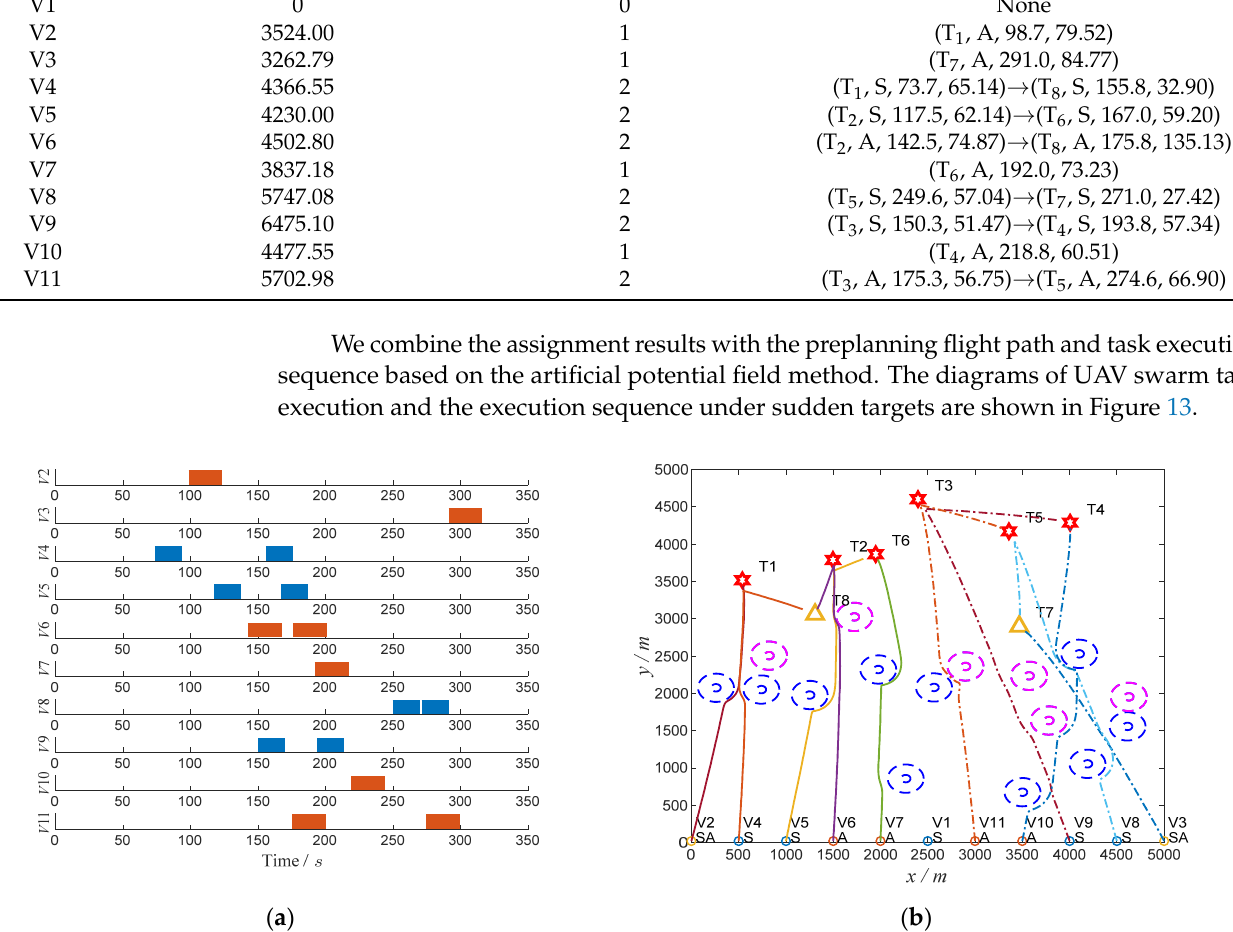
Table 9. The bidding values of potential bidders for dynamic subtasks.